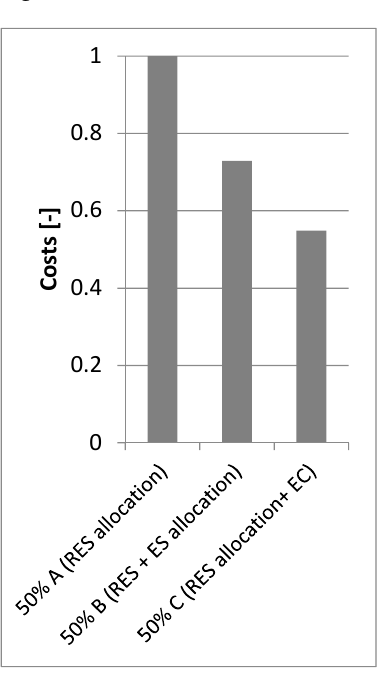
Figure 9. Costs for main scenarios—3.